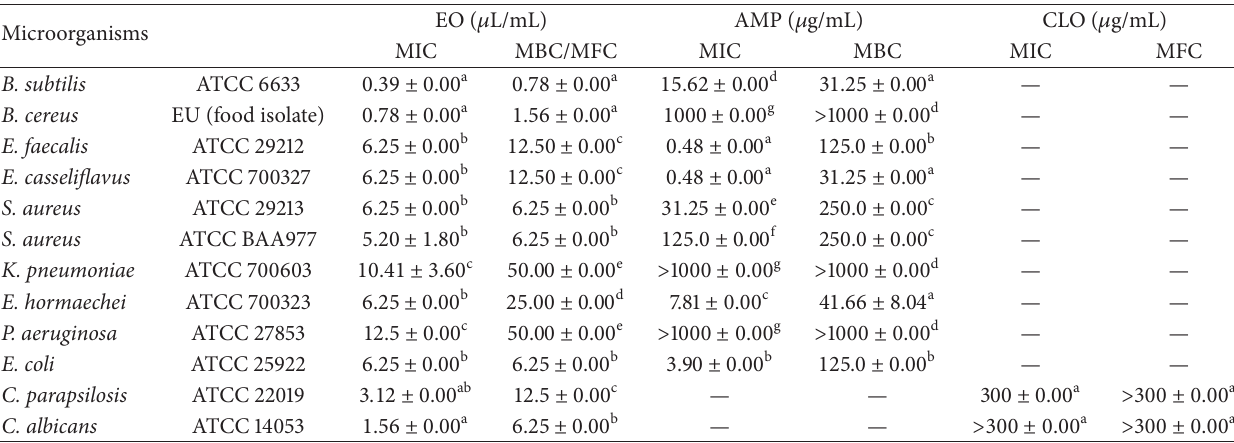
Table 5: Minimum Inhibitor Concentration and Minimum Bactericidal/Fungicidal Concentration values of T. cilicicum essential oil.